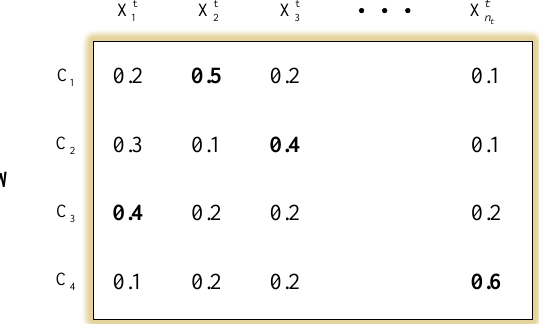
belonging to class C i are j